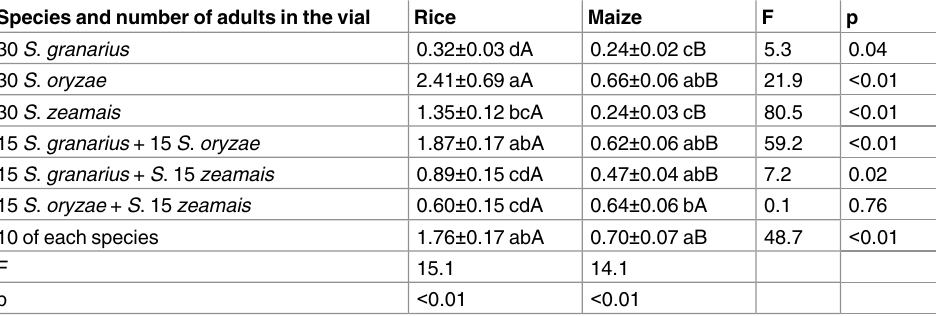
< 0.01 < 0.01 Within each column, means followed by the same lowercase letter are not significantly different (Tuckey- Kramer HSD test at p = 0.05; for rice df = 6, 37, for maize df = 6, 56). Within each row, means followed by the same uppercase letter are not significantly different (Tukey-Kramer HSD test at p = 0.05; df ranged between 1, 10 and 1,